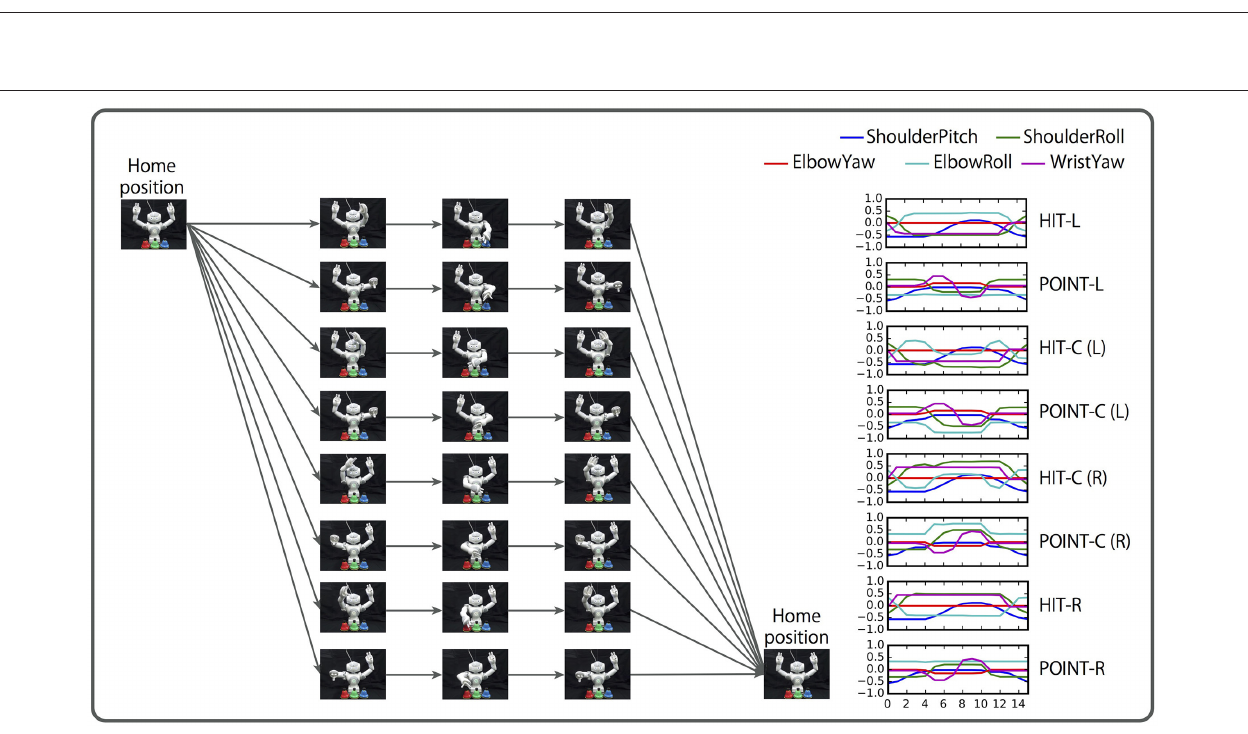
FIGURE 12 | Overview of the bell task. A human places three bells colored red, green, and blue in random order. The human gives the robot an instruction consisting of a combination of a verb (“hit,” “point”), an objective (“red,” “green,” “blue”), and an adverb (“slowly,” “quickly”). When the left or right bell is indicated, the robot must hit (point at) the bell with the closer hand. In the case of the center bell, the robot may hit (point at) it with either arm. Two color words can be concatenated by “and”. In this case, the robot must act to both bells simultaneously (not presented in this figure). Two color words also can be concatenated by “or,” in which case the robot may hit (point at) either bell. In another case, the logic word “not” can be prefixed to a color word. In this case, simultaneously hitting (pointing at) the two bells that are the complementary set of the indicated color is the correct response.